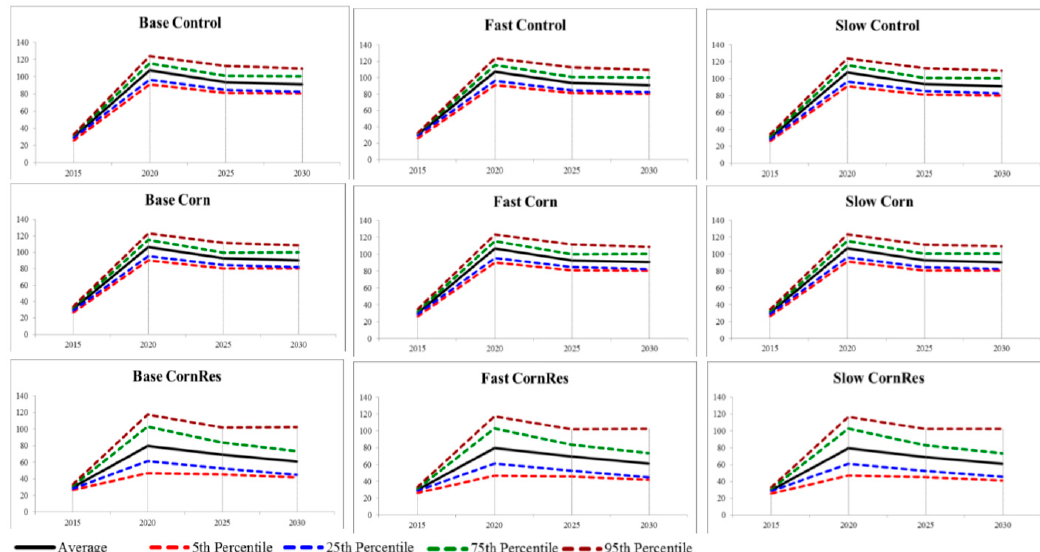
Figure A1. Variability of U.S. cropland used for biofuel production (in million acres) stochastic draw during 2015 to 2030 under various biofuel policy and demand growth scenarios.